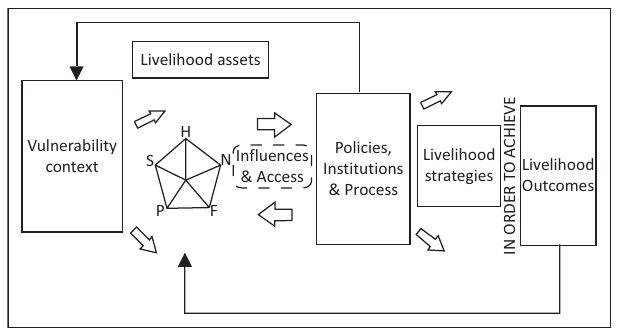
FIGURE 1: The Sustainable Livelihood